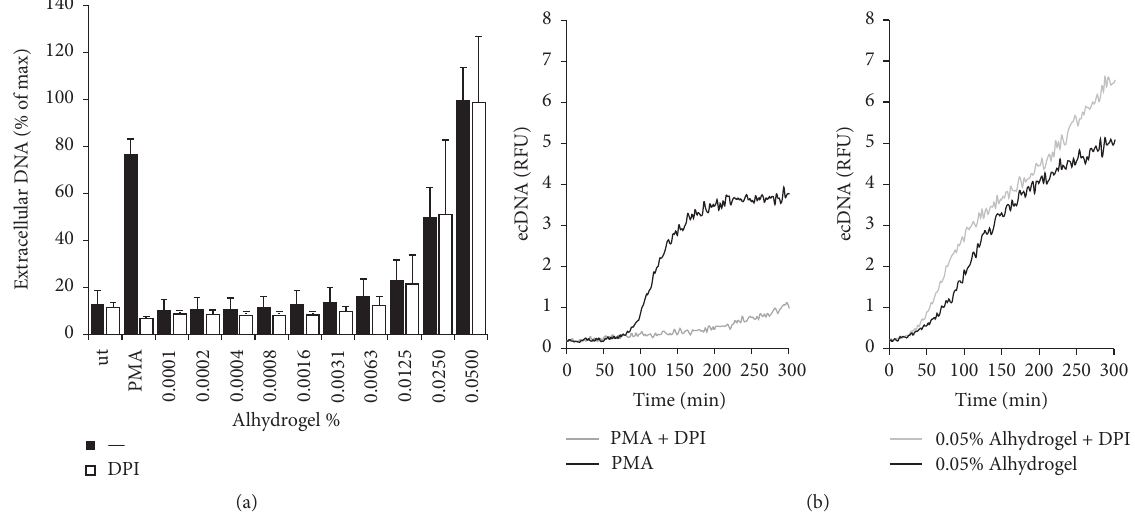
Figure 3: PMNs release extracellular DNA in response to Alhydrogel in vitro. Human PMNs seeded on a 96-well black microplate were incubated for 30 minutes in the presence or absence of 10 𝜇 M DPI prior stimulation with increasing doses of commercially available Alhydrogel (InvivoGen, cat#: vac-alu-50) or 100 nM PMA. Increase in fluorescence due to extracellular DNA (ecDNA) release was measured in presence of 10 𝜇 M Sytox Orange DNA-binding dye for 5 hours with a microplate fluorimeter. DNA release is presented as either relative fluorescence units (RFU) or percentage of maximal DNA released achieved by saponin treatment [4, 20]. (a) Summary of three independent experiments using PMNs obtained from independent human donors. Mean +/ − SEM. (b) Representative kinetics of fluorescence results ( 𝑛 = 3 ). Ut, untreated; PMA, phorbol myristate